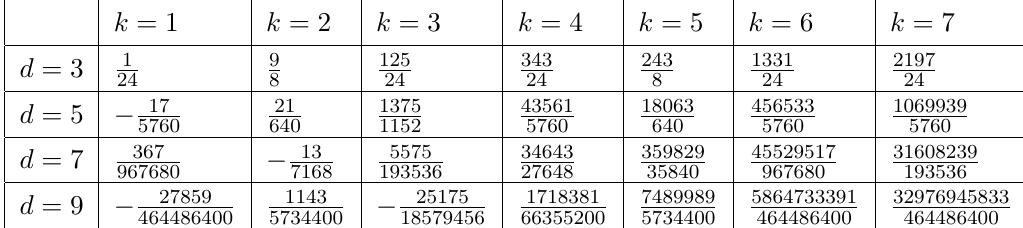
GJMS kinetic operator on HS d for various odd d and k with 2 k